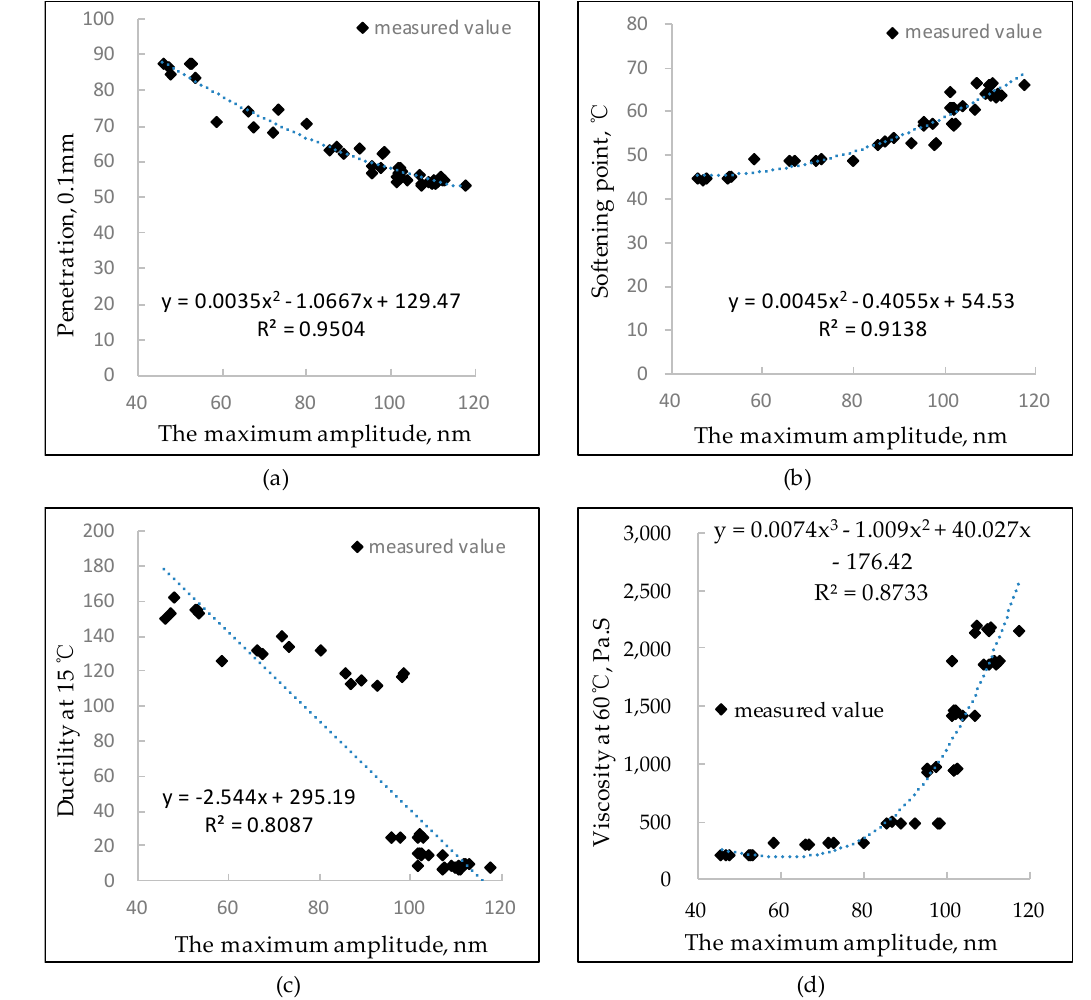
Figure 13. The relationships between the maximum amplitude and technical indexes. ( a ) penetration at 25 °C; ( b ) softening point; ( c ) ductility at 15 °C; ( d ) viscosity at 60 °C. The maximum amplitude is intrinsically related to the development of the bee-like